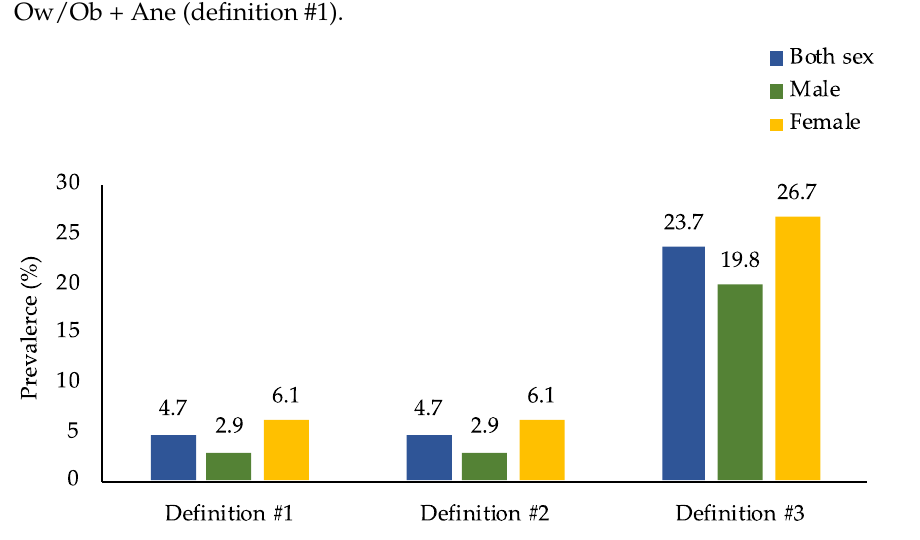
Figure 2. Prevalence of the co-occurrence of overweight/obesity and micronutrient deficiencies among overweight/obese adults in the Philippines by sex (n = 4816). Prevalence estimates accounted for the complex sampling design. Definition #1: overweight/obesity and anemia. Definition #2: overweight/obesity and anemia or vitamin A deficiency. Definition #3: overweight/obesity and anemia or vitamin A deficiency or iodine insufficiency.